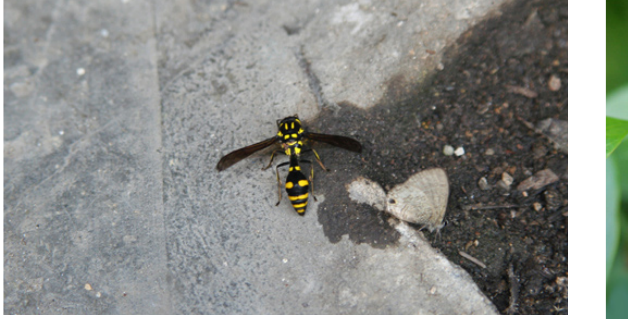
Image 9. Pareumenes quadrispinosus (de Saussure, 1855) female. Image 10. Rhynchium brunneum (Fabricius, 1793)